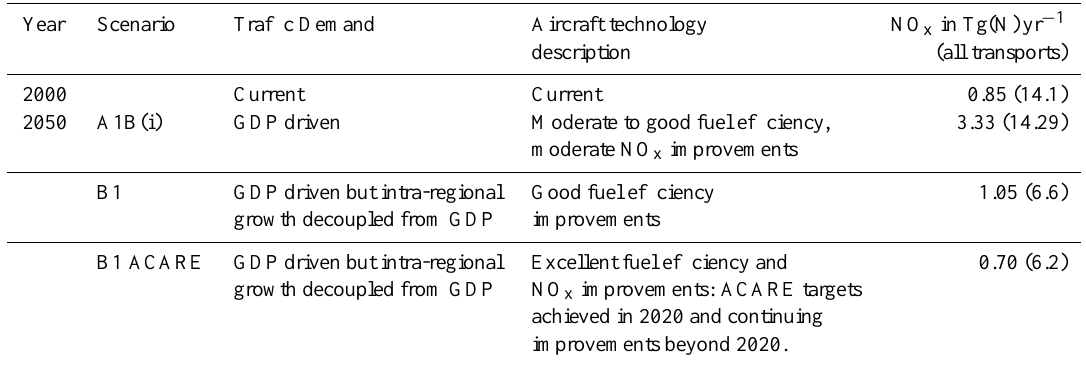
Table 3. Present 2000 and future (2050) global NO x emissions by aircraft (and all transport